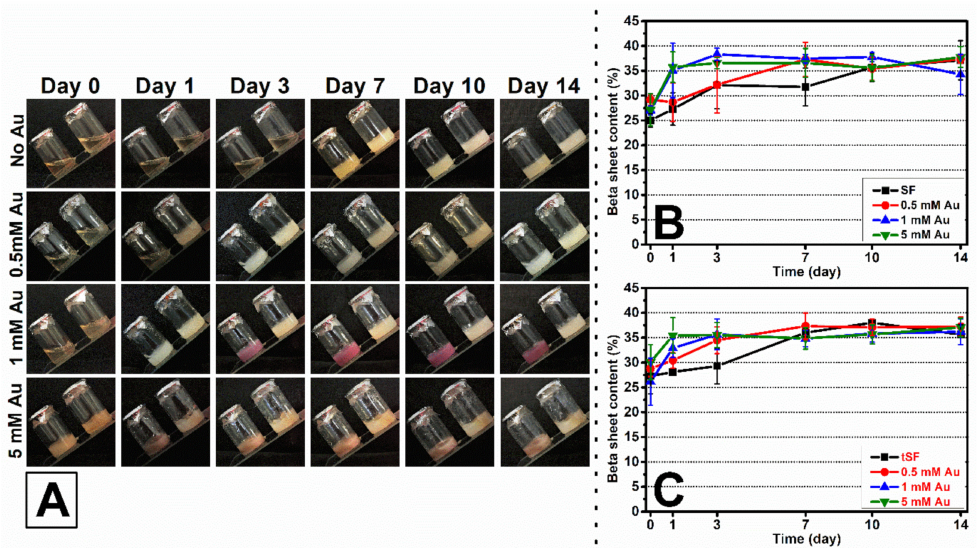
Figure 2. ( A ) Appearances of regenerated (no Au 3 + ) and Au 3 + -mediated SF (left vial) and tSF (right vial) hydrogels incubated at 37 ◦ C over 14 days. The amount of beta sheet determined from FTIR spectra using Fourier self-deconvolution (FSD) and curve-fitting techniques of the freeze-dried regenerated SF ( B ) and tSF ( C ) at di ff erent Au 3 +